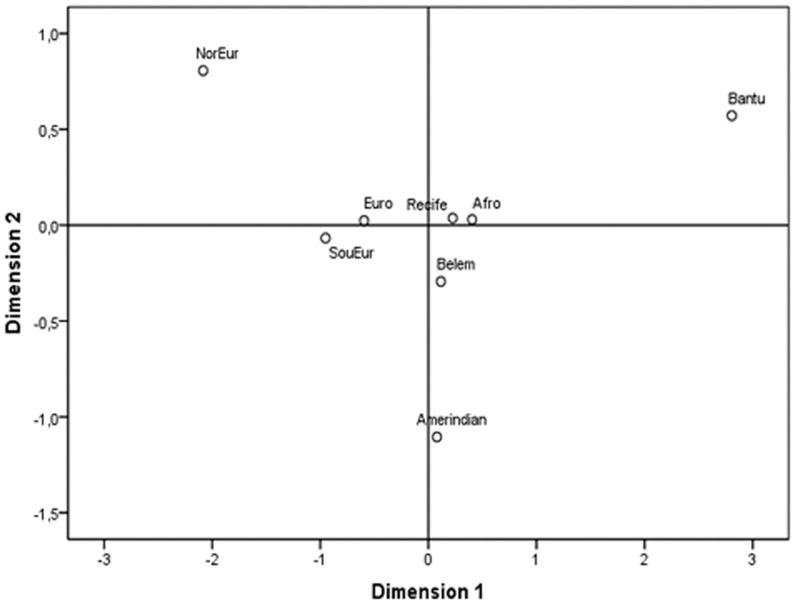
MDS of several populations LCT haplotypes.Nonmetric Multidimensional Scaling analysis of LCT haplotypes based on DA distance showing the relationships among the four Brazilian populations with their parental groups: Brazilian Amerindians [26]; Southern Europeans, Northern Europeans, and Bantu-speaking South Africans [14]. NorEur  =  Northern European, SouEur  =  Southern European, Euro  =  Porto Alegre Euro-descendant, Afro  =  Porto Alegre Afro-descendant.